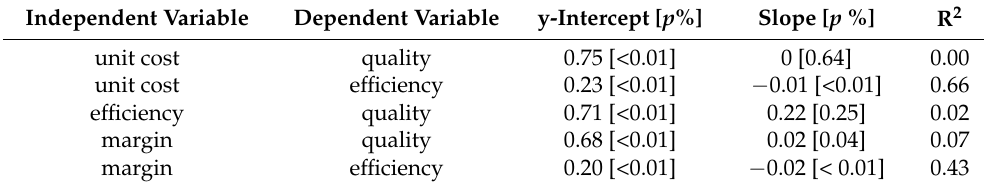
Table 3. Regression analysis